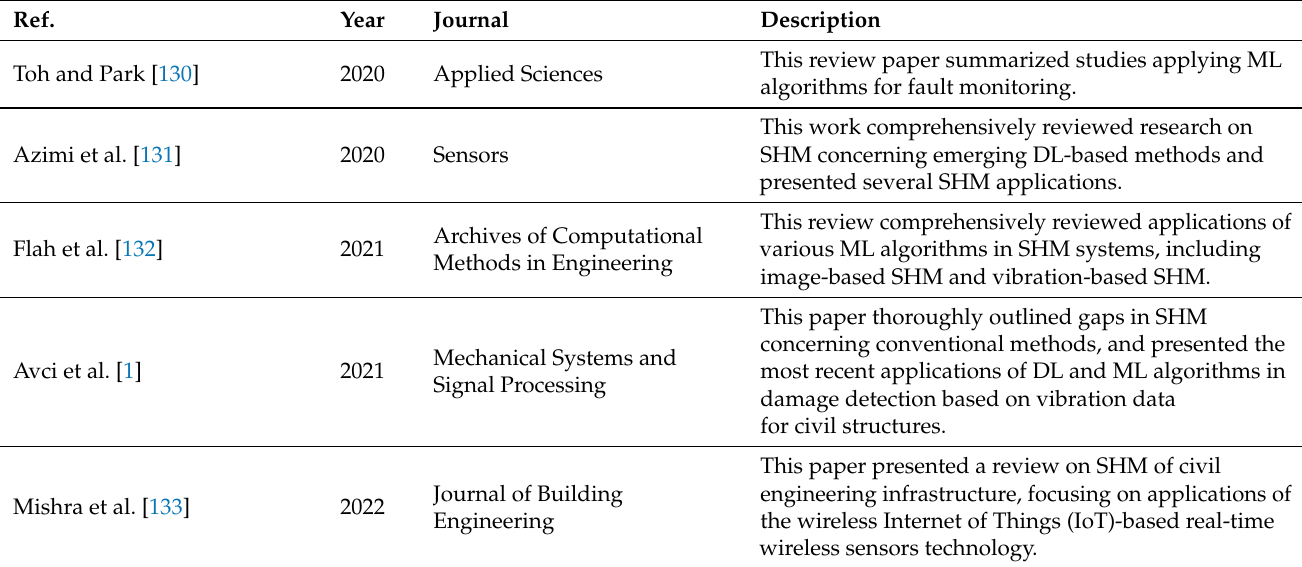
Table 9. Recent review papers on SHM